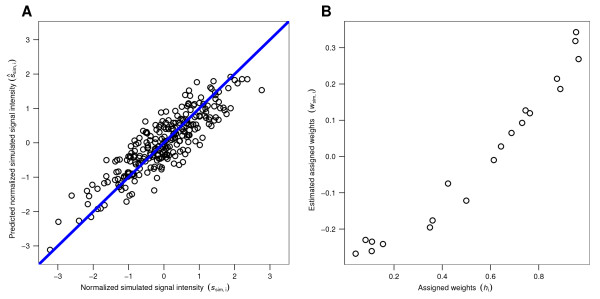
Simulated signal intensities and assigned amino acid-associated weights are recovered by an amino acid composition-based regression model. (A) Simulated signal intensities (s →sim) obtained by amino acid position-dependent simulation of the binding of 150 antibodies to an array of 255 14-mer peptides were predicted using the regression model given by Equation 1. This regression model takes into account only the amino acid composition of the simulated peptide sequences. Predictive performance: Q2 = 0.40. Simulated signal intensities were computed using Equation 2. (B) Equation 1 was used to estimate (w →sim), which are shown against the assigned AAWS (h →) used to generate the simulated signal intensities s →sim. Coefficient of correlation: r = 0.92.